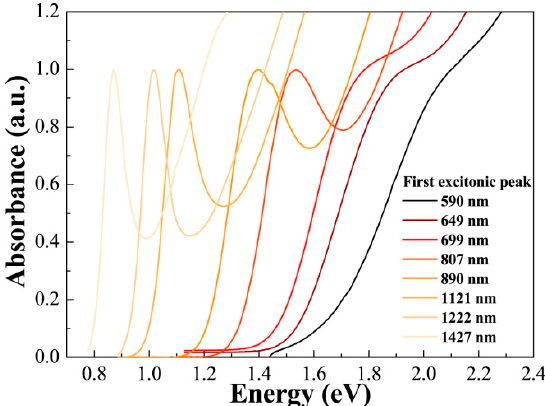
Figure 8. Absorption spectra of PbS quantum dots synthesized at temperatures between 45 °C and 185 °C. From [84], reprinted with permission. Copyright © Elsevier 2019. 185 ◦ C. From [84], reprinted with permission. Copyright © Elsevier